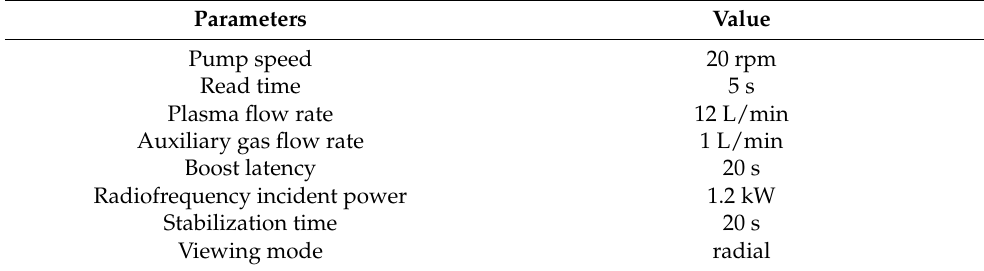
Table 1. Operating conditions for ICP-OES.